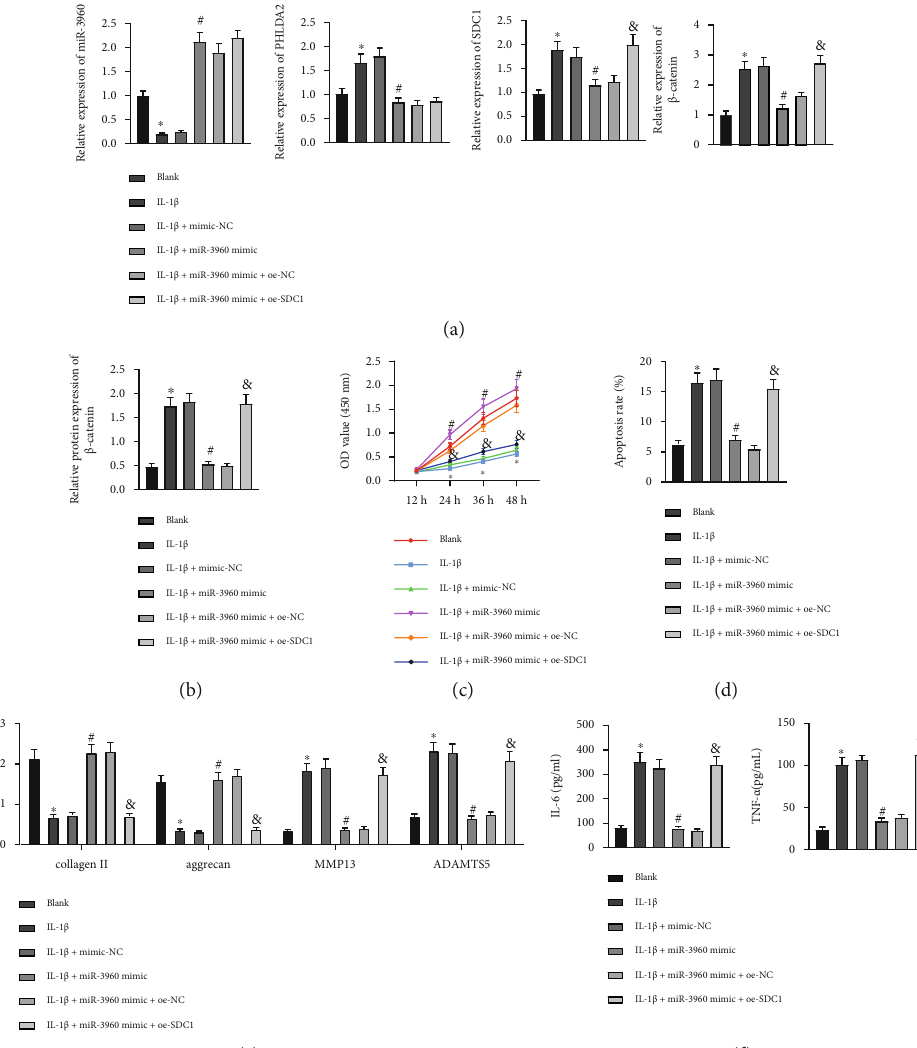
Figure 7: miR-3960 PHLDA2/SDC1/Wnt/ β -Catenin axis to suppress chondrocyte in fl ammation and ECM degradation. Chondrocytes were treated with IL-1 β , miR-3960 mimic, and/or oe-SDC1. (a) miR-3960 expression and mRNA levels of PHLDA2, SDC1, and β -catenin in chondrocytes determined by RT-qPCR. (b) Protein levels of PHLDA2, SDC1, and β -catenin in chondrocytes determined by immunoblotting. (c) Cell proliferation assessed by CCK8 assay. (d) Apoptosis assessed by fl ow cytometry. (e) Protein levels of collagen II, aggrecan, MMP13, and ADAMTS5 in chondrocytes measured by immunoblotting. (f) Levels of IL-6 and TNF- α in chondrocytes measured by ELISA. ∗ p < 0 : 05 vs. chondrocytes without treatment; # p < 0 : 05 vs. chondrocytes treated with IL-1 β +mimic-NC; & p < 0 : 05 vs. chondrocytes treated with IL-1 β +miR-3960 mimic+oe-NC. Data are shown as the mean ± standard deviation of three technical replicates. Data between two groups were compared by independent t- test. Data comparisons among multiple groups were analyzed by the one-way ANOVA with Tukey ’ s post hoc test, and comparison of data at di ff erent time points was analyzed using repeated measurement ANOVA with Tukey ’ s post hoc